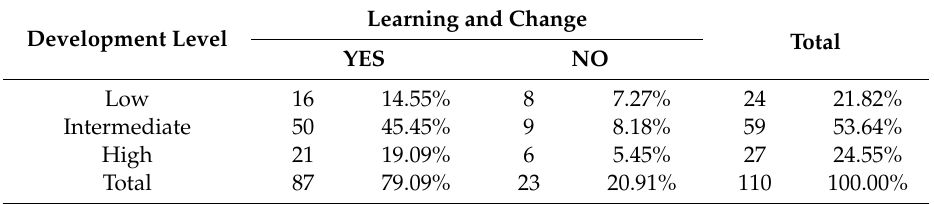
Table 3. Contingency table of absolute and relative (as % of the total) frequencies of PMM system development level and ability to learn from mistakes and adapt to